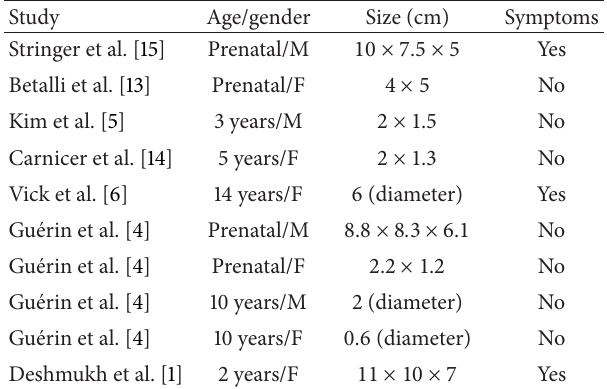
Table 1: Demographic and clinical description of the 10 pediatric and adolescent patients of